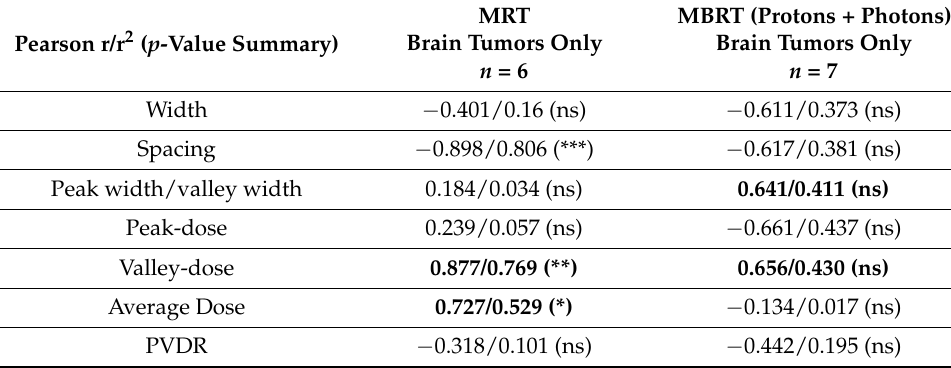
Table 4. Correlation coefficients for the studies including only brain tumors.